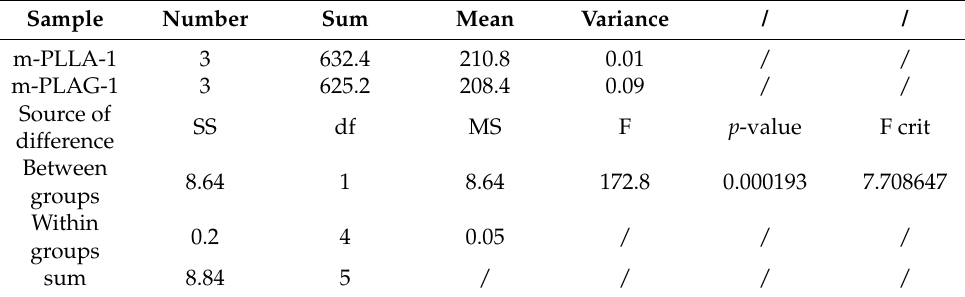
Table 3. One-way ANOVA for f c,SC of m-PLLA-1 and m-PLAG-1.